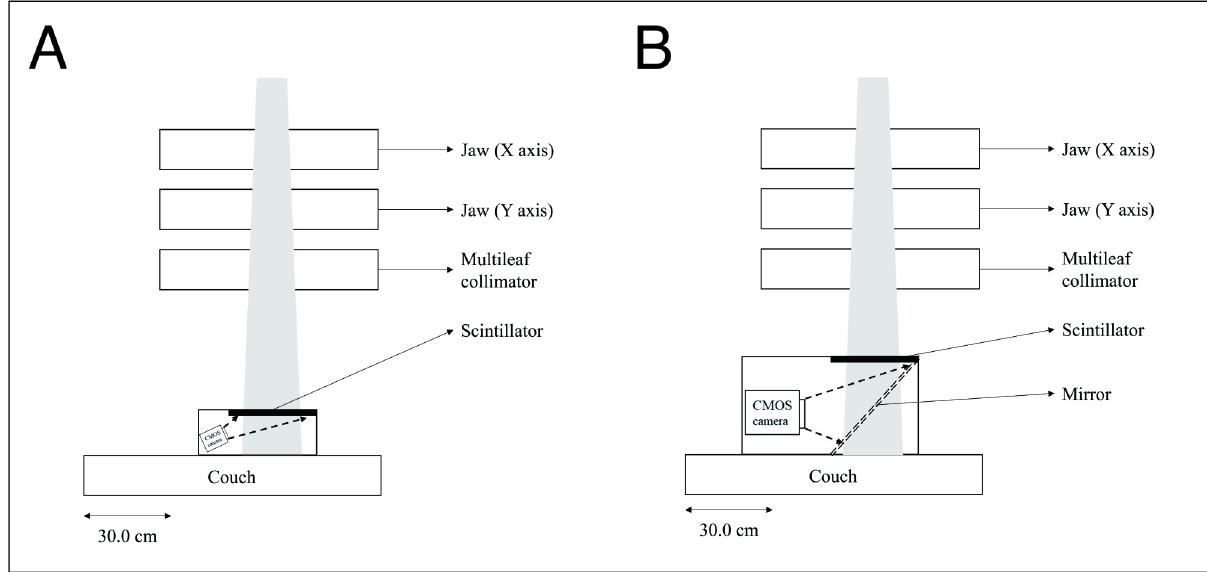
Fig 1. Diagram of the scintillation detector: (A) Developed TRMLSD and (B) conventional scintillation detector with a mirror.